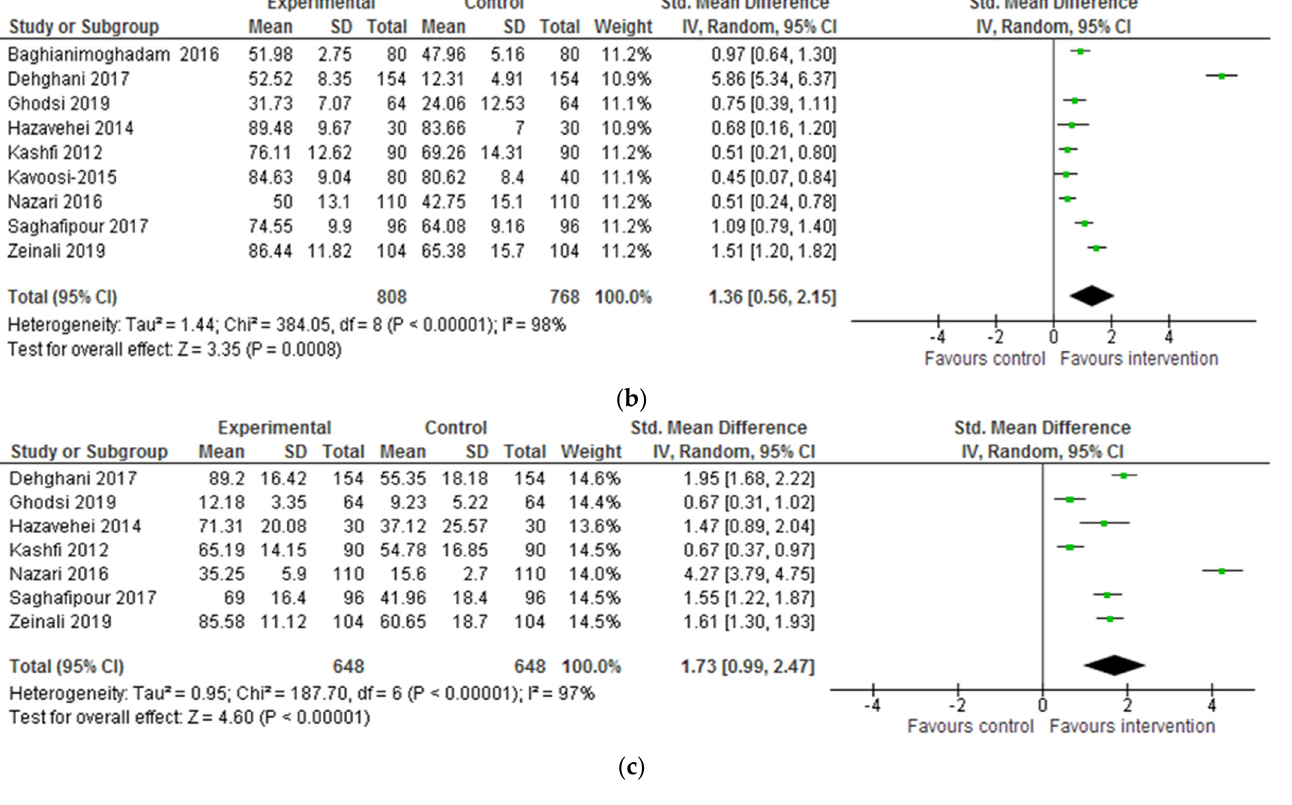
Figure 2. ( a ) Forest plot for the impact of the intervention on CL-related knowledge. ( b ) Forest plot for the impact of the intervention on CL-related attitudes. ( c ) Forest plot for the impact of the intervention on CL-related behaviours/ practices.